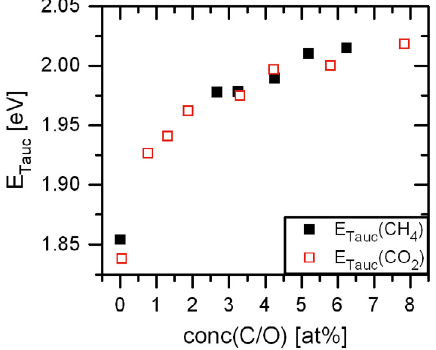
Fig. 4. Tauc bandgap of amorphous silicon alloy single layers against C or O concentration from EBS.